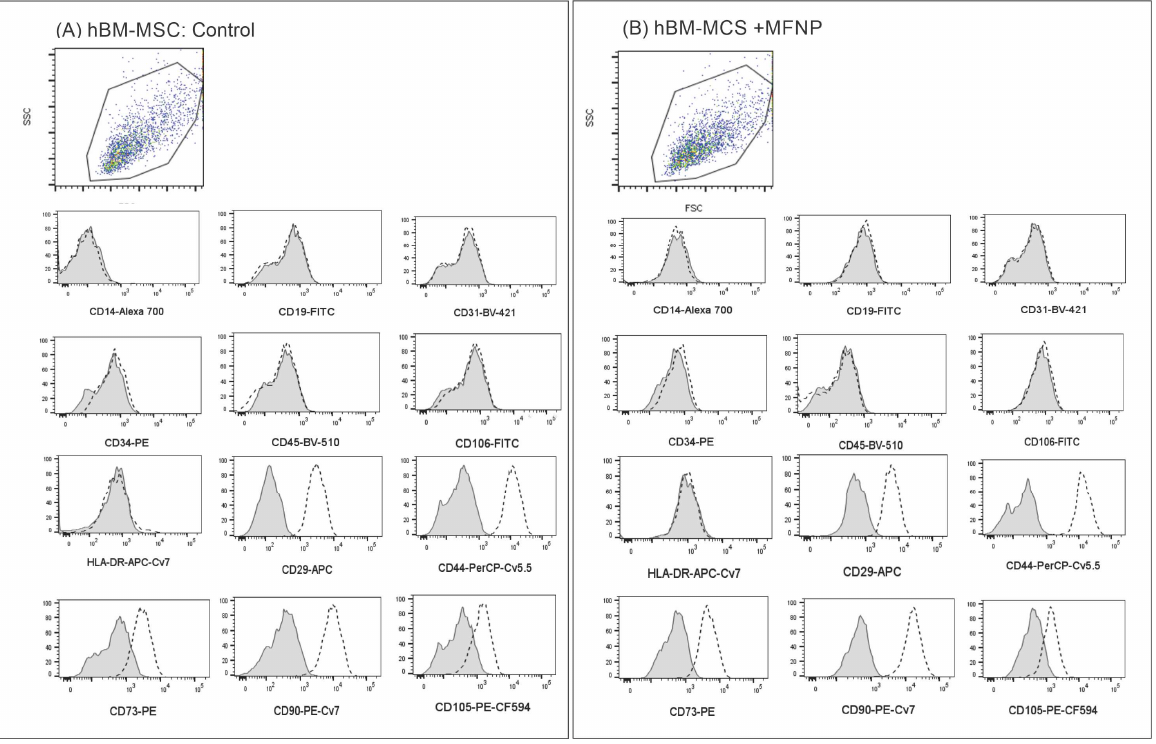
Figure 1. Flow cytometry evaluation comparing the hBM-MSC. ( A ) unlabeled with MFNP and ( B ) labeled with 50 µg Fe/mL of MFNP.